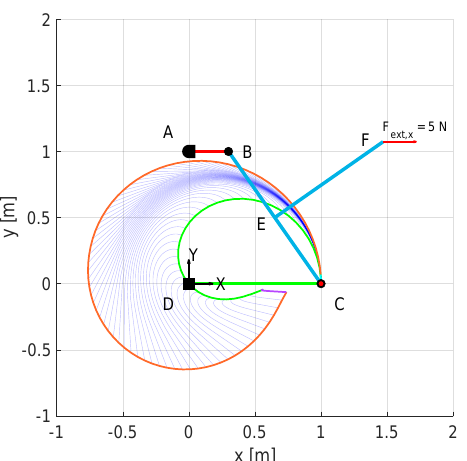
Figure 10. Cycle with buckling mode changes. Initial position.